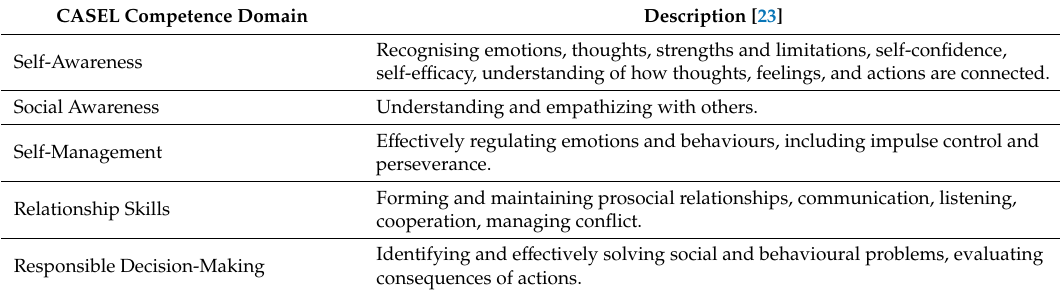
Table 1. Collaborative for Academic, Social and Emotional Learning (CASEL) Social and Emotional Learning